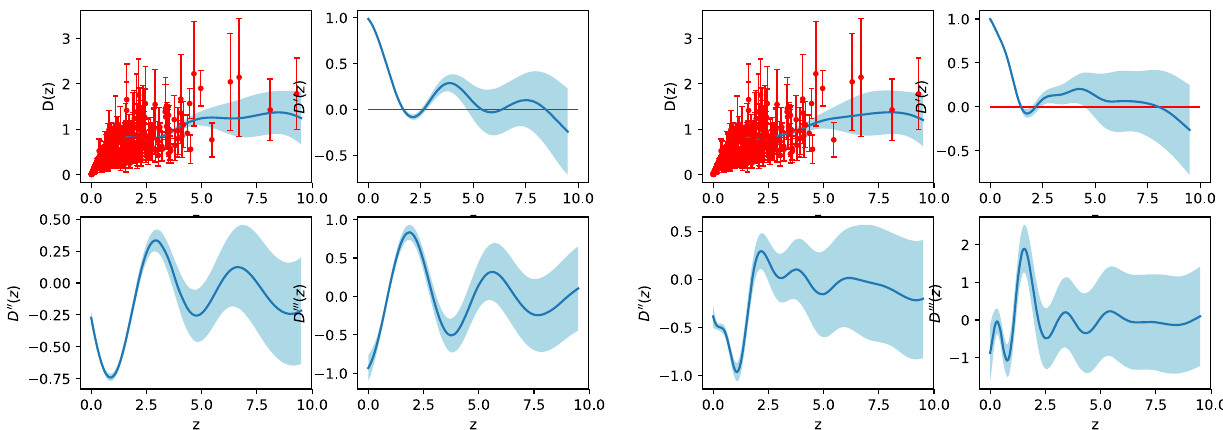
Fig. 5 Left panel: The reconstruction of D ( z ) and its derivatives as a function of redshift using Gaussian kernel for all data set. Right panel: The same plot using Matern ( ν = 7 / 2) kernel and the same data set